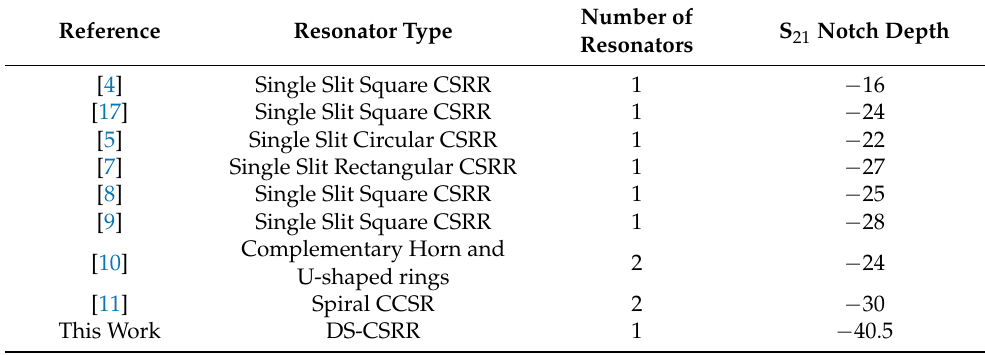
Table 3. Performance comparison of metamaterial